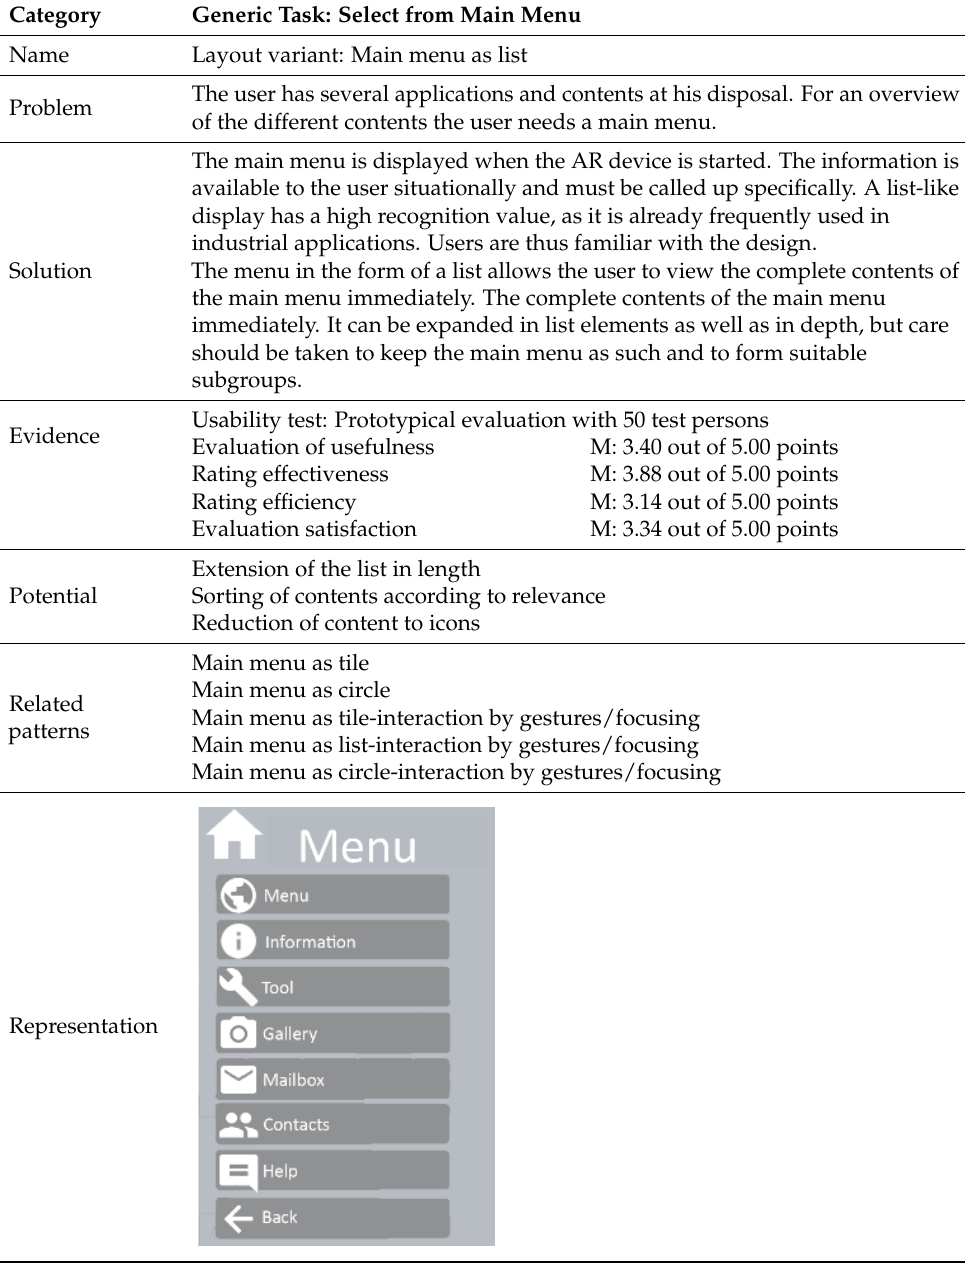
Table 12. Examples from the catalog with pattern. Part 1: Variants of the layout.